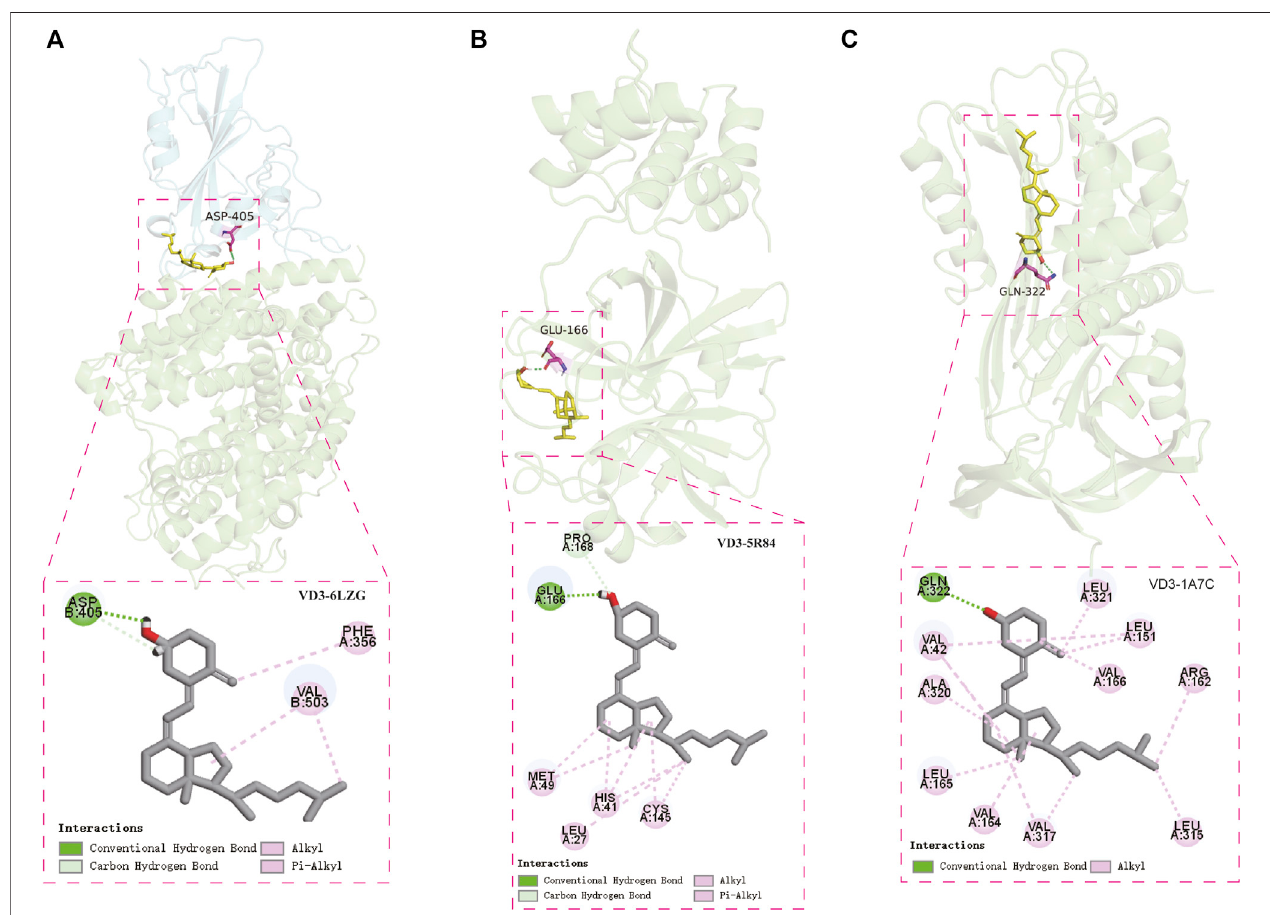
FIGURE 6 | Con fi rmation of vitamin D3 binding to STAD/COVID-19 targets. (A) Molecular docking model of VD3 with SARS-COV-2 Spike RBD/ACE2 complex [PDB: 6LZG, ACE2 (green), SARS-CoV-2 RBD (cyan)] and 2D patterns of bonds in the model. (B) Molecular docking model of VD3 with SARS-CoV-2 major protease (PDB: 5R84) and 2D patterns of bonds in the model. (C) Molecular docking model of VD3 with PAI1 (PDB: 1A7C) and 2D patterns of bonds in the model.